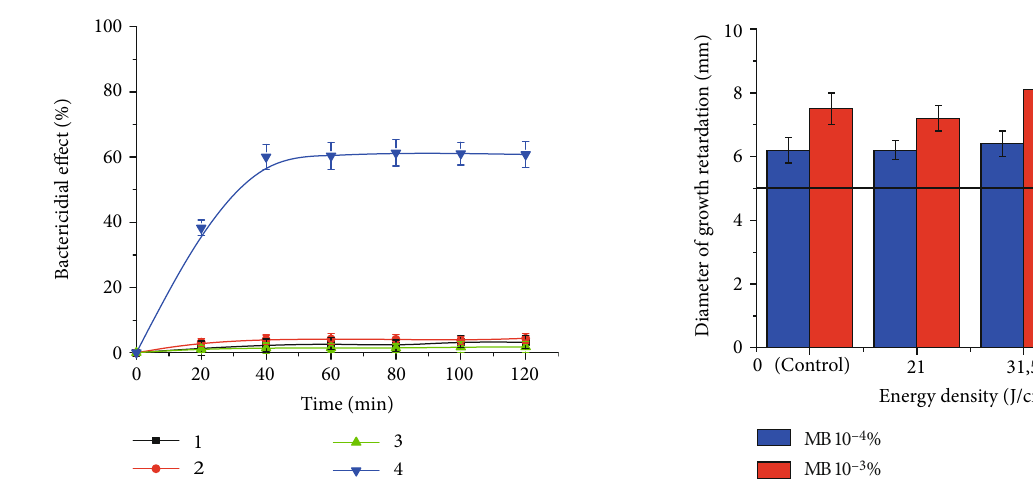
Figure 5: Bactericidal e ff ect of red light (660nm) (1), methylene blue (10 -4 wt.%) (2), pure D20-PAA-0.2 (3), and D20-PAA-0.2 loaded with MB and activated by red light (660nm) (4) in suspension of wild strains S. aureus . Energy density = 6 J/cm 3 , M ± SD .